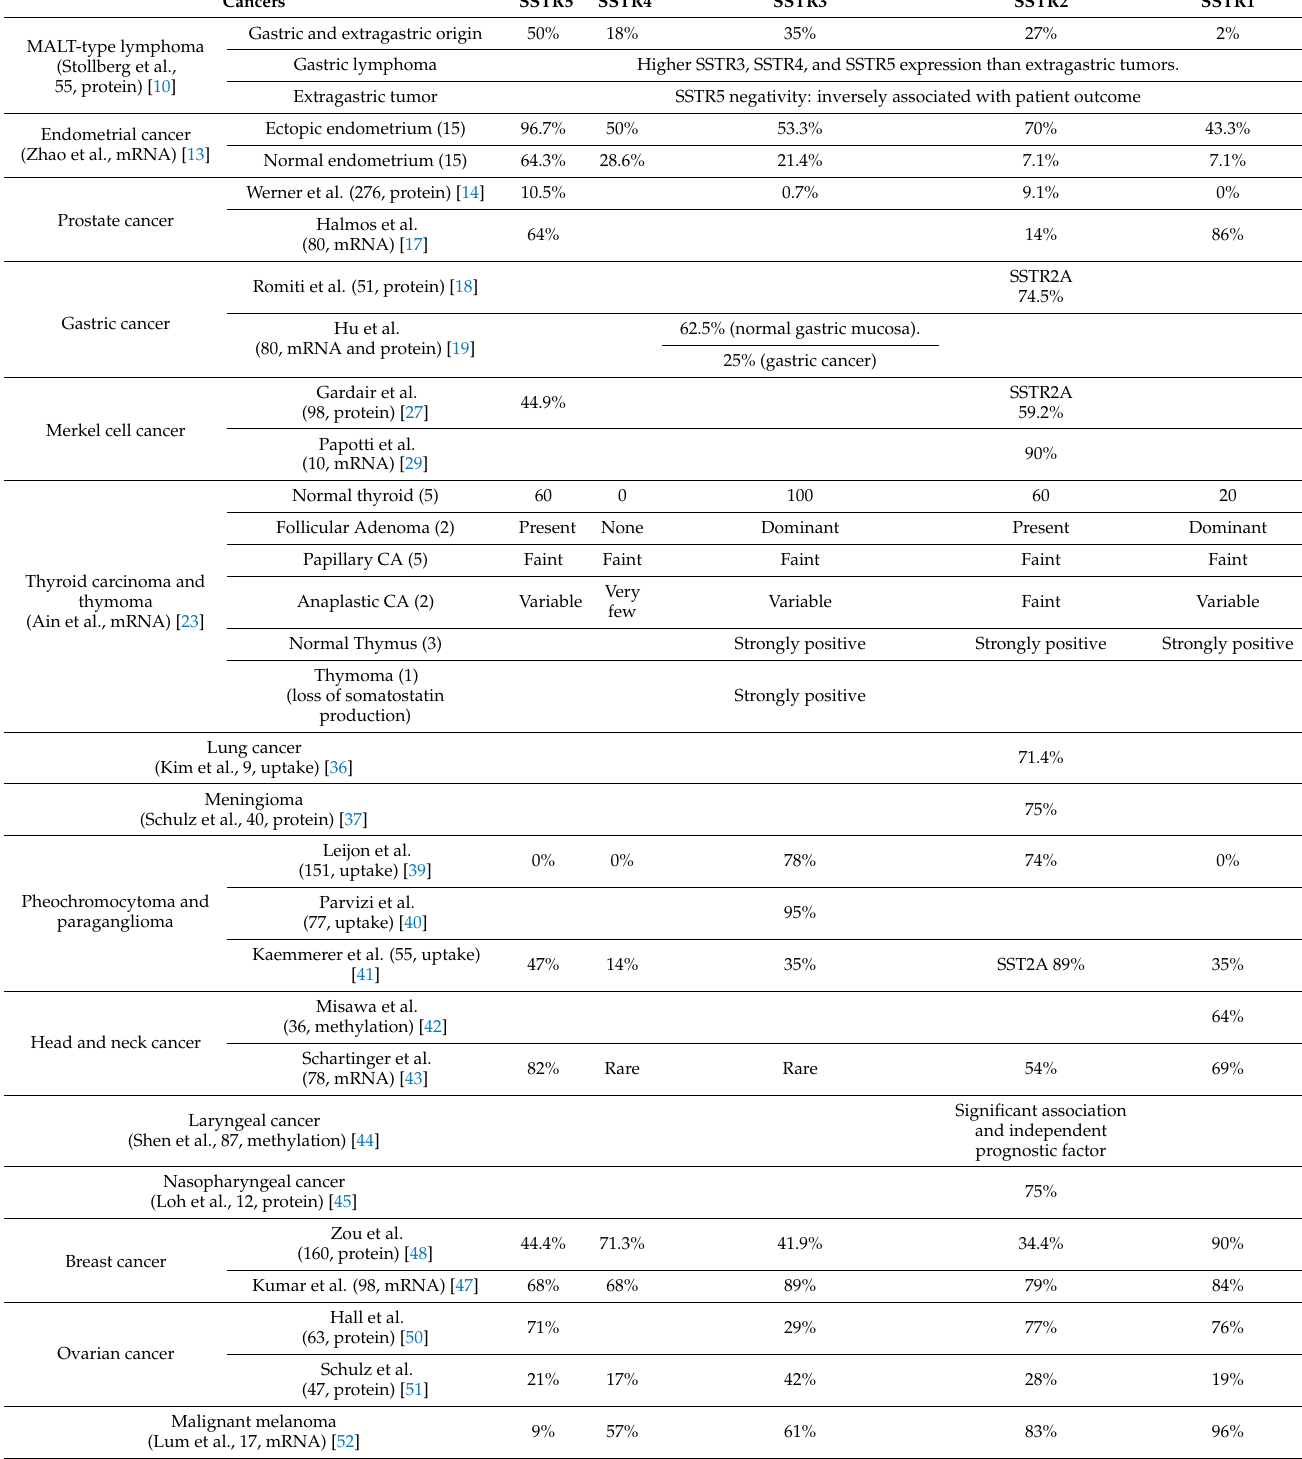
Table 1. Tabular presentation of somatostatin receptor prevalence in various cancers. (The name of the study, number of patients in the study and the analysis are included in